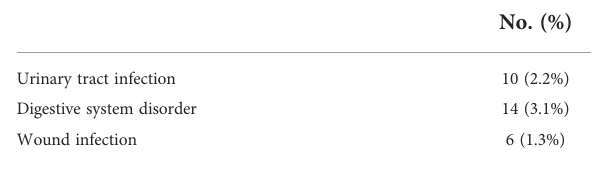
TABLE 1 Baseline characteristics of study participants